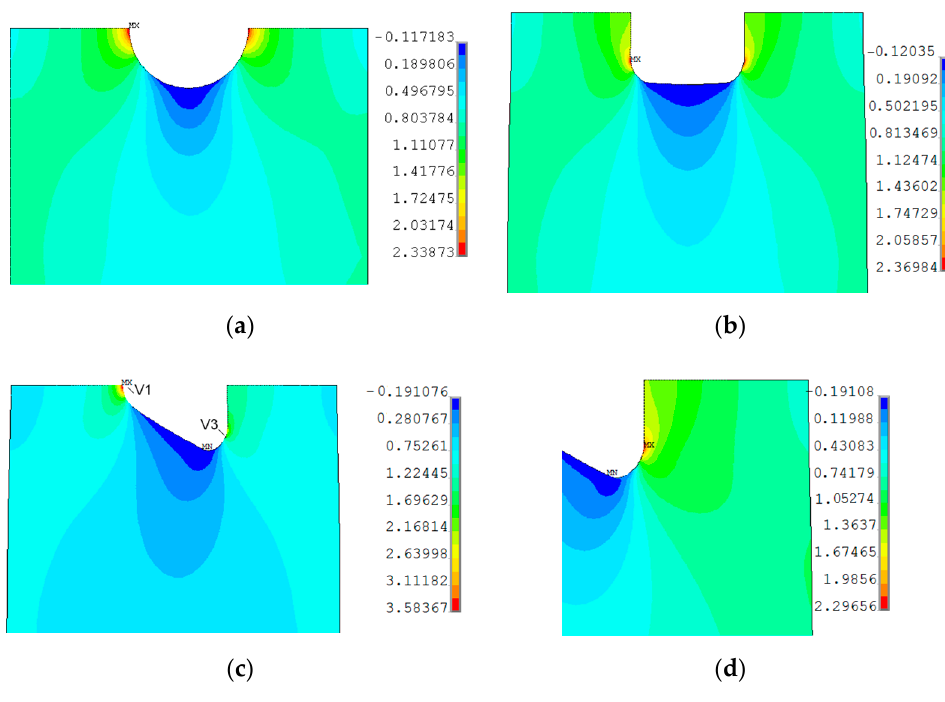
Figure 6. Stress concentration factor for specimens made of S235JR with: ( a ) circular hole; ( b ) square hole, fillet radius R5; ( c ) triangular hole, Corner V1; and ( d ) triangular hole, Corner V3.